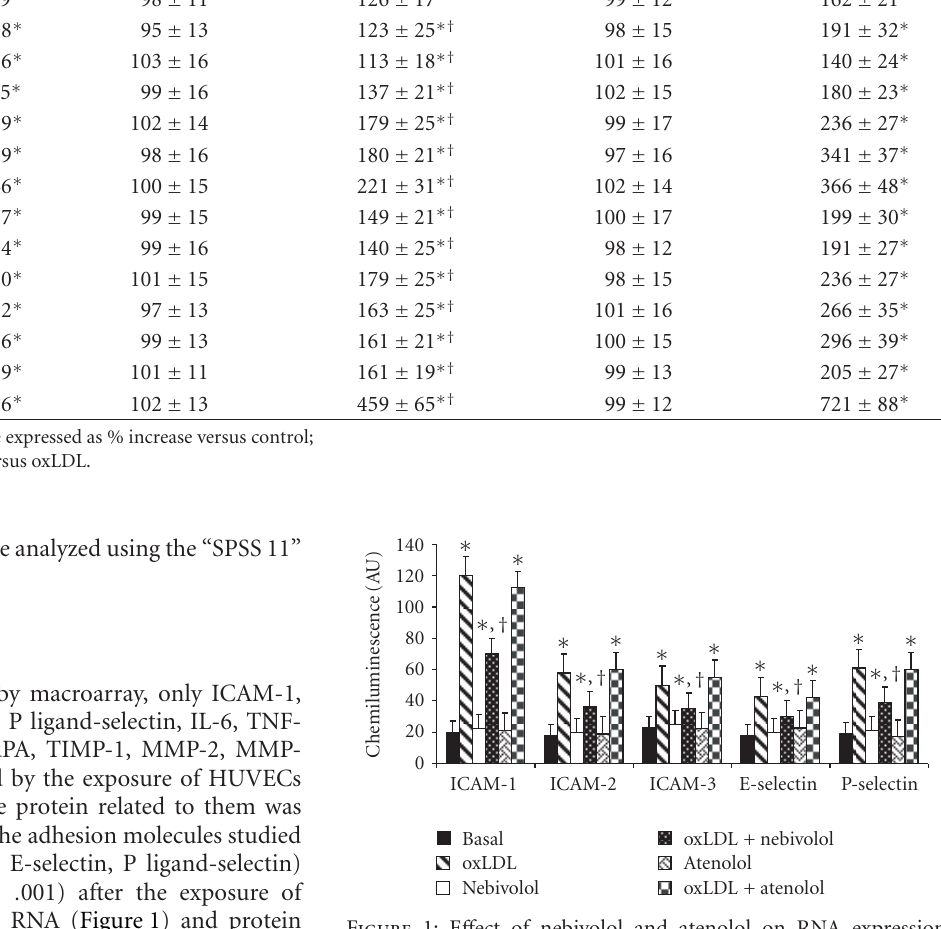
Figure 1: E ff ect of nebivolol and atenolol on RNA expression of adhesion molecules (ICAM-1, ICAM-2, ICAM-3, E-selectin, and P-selectin) induced by oxidative stress in human umbilical vein endothelial cells (HUVECs). HUVECs were incubated with nebivolol or atenolol (10 μ M) for 24 hours at 37 ◦ C; oxidative stress was induced by the addition of oxidized (ox)LDL (50 μ g protein mL − 1 ). ∗ P < . 001 versus control; † P < . 01 versus ox-LDL. AU = arbitrary units. Data are expressed as means ± SD of 6 di ff erent